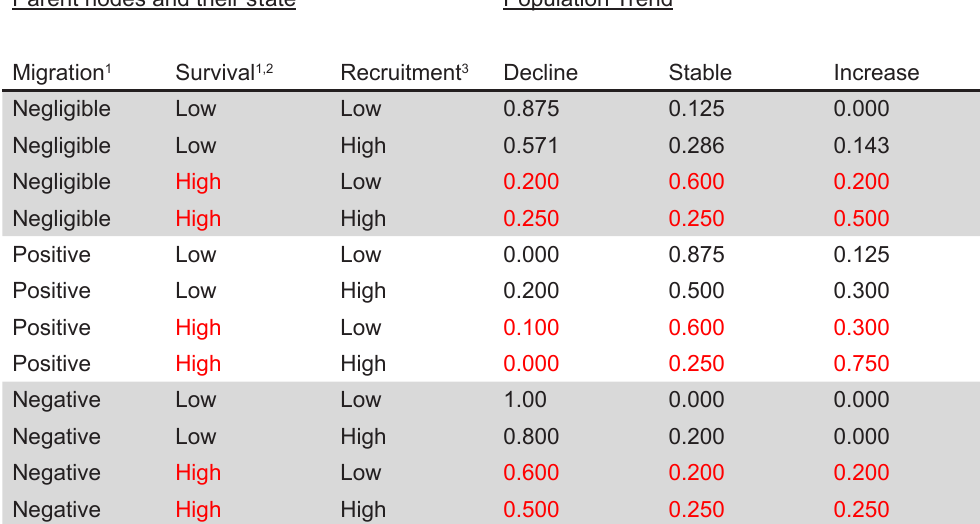
Table A2. Conditional probability table for node population trends.